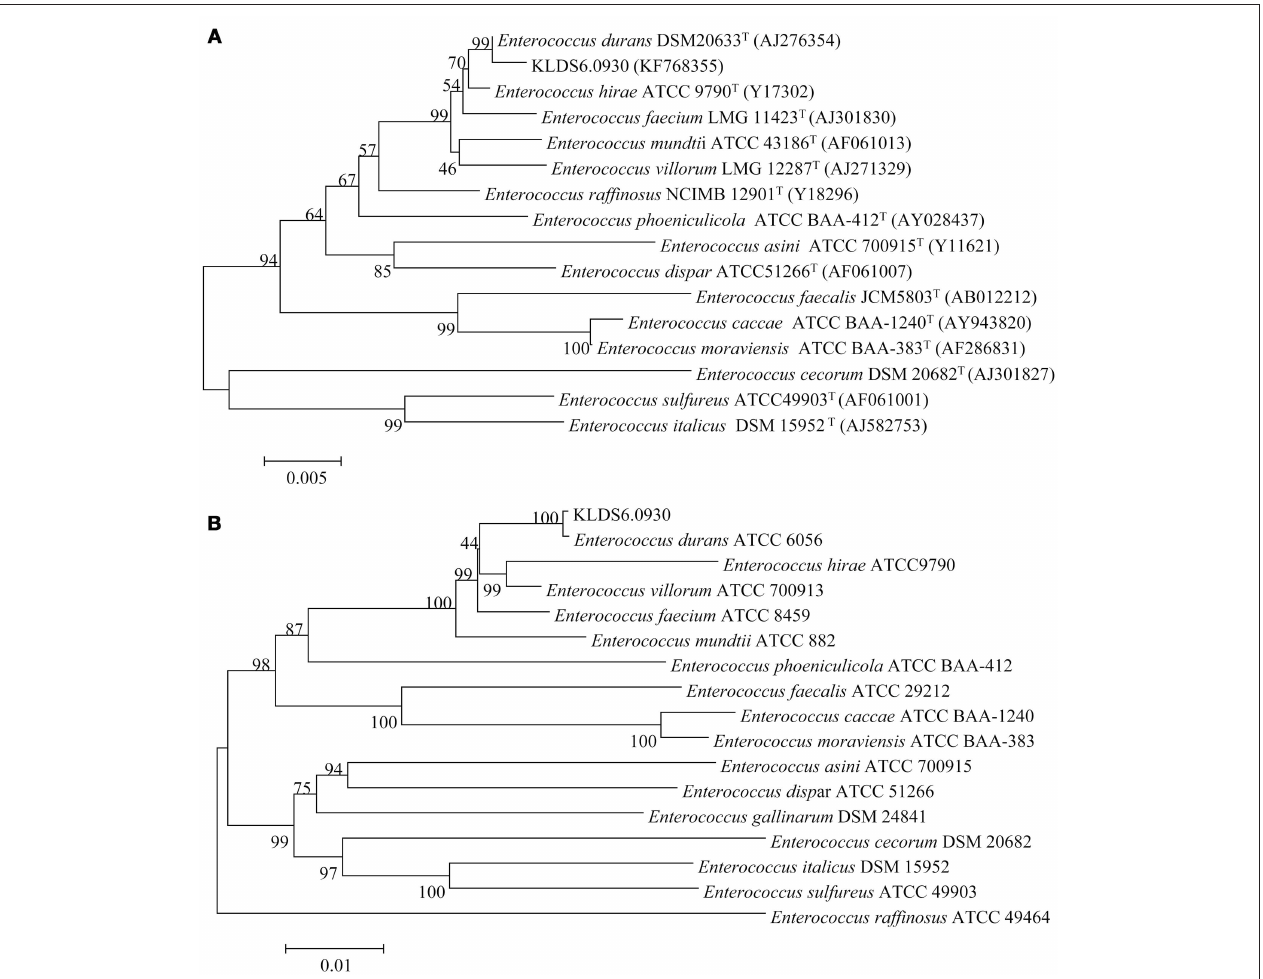
FIGURE 1 | Phylogenetic trees of 16S rRNA gene (A) and concatenated 49 ribosomal protein sequences (B) using MEGA 7.0 software with the neighbor-joining method. Bootstrap values based on 1,000 resampled datasets are shown at branch